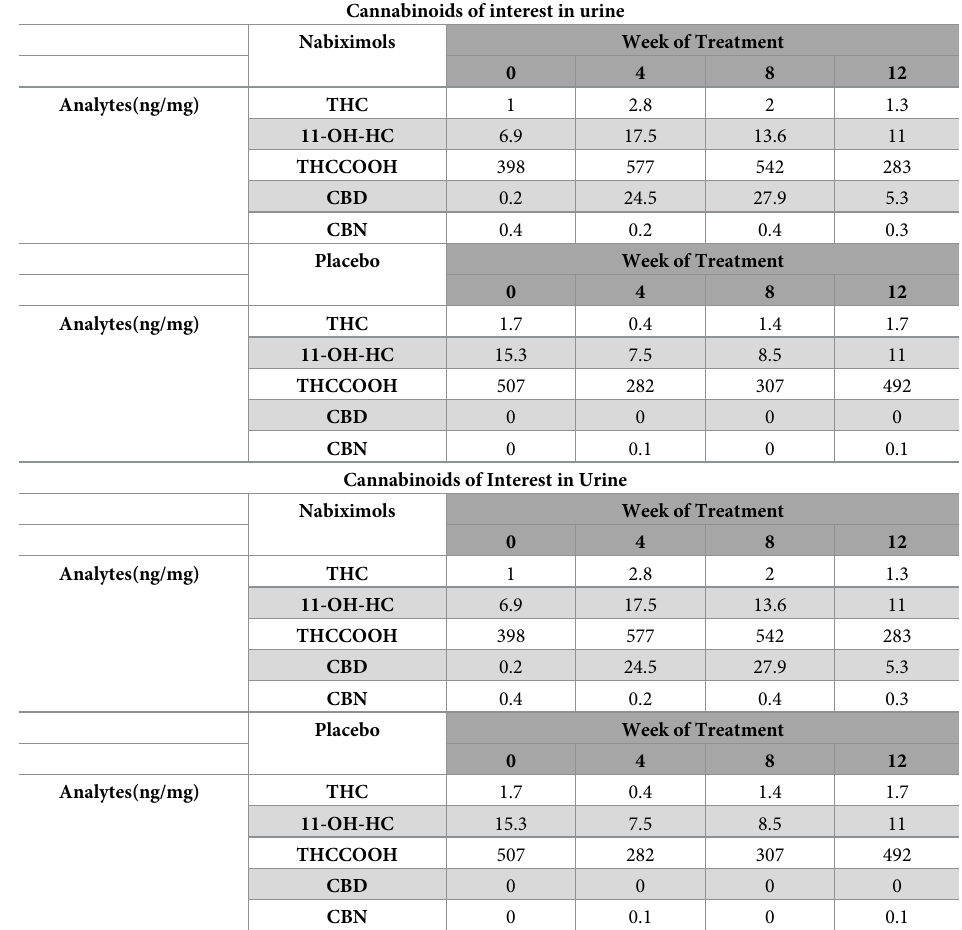
Table 2. Cannabinoids of interest in urine were quantified using two-dimensional gas chromatography-mass spectrometry (2D-GCMS). Table represents creatinine-normalized mean urine Δ 9-tetrahydrocannabinol (THC), 11-hydroxy-THC (11-OH-THC), 11-nor-9-carboxy-THC (THCCOOH), cannabidiol (CBD) and cannabinol (CBN) concentrations for nabiximols and placebo